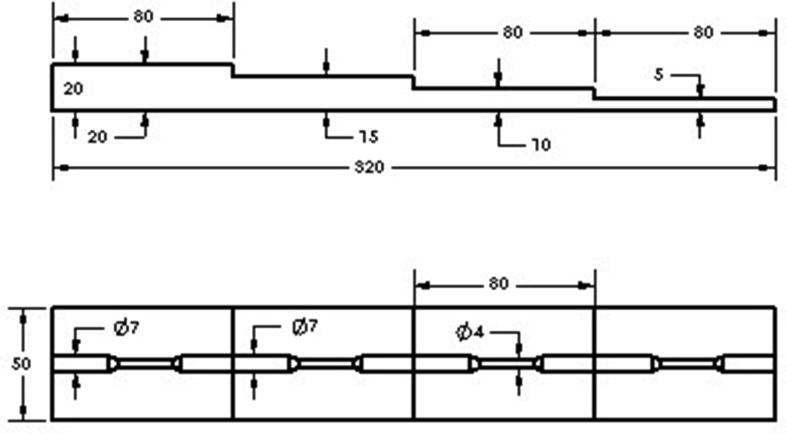
Step block cast with different thicknesses in mm.